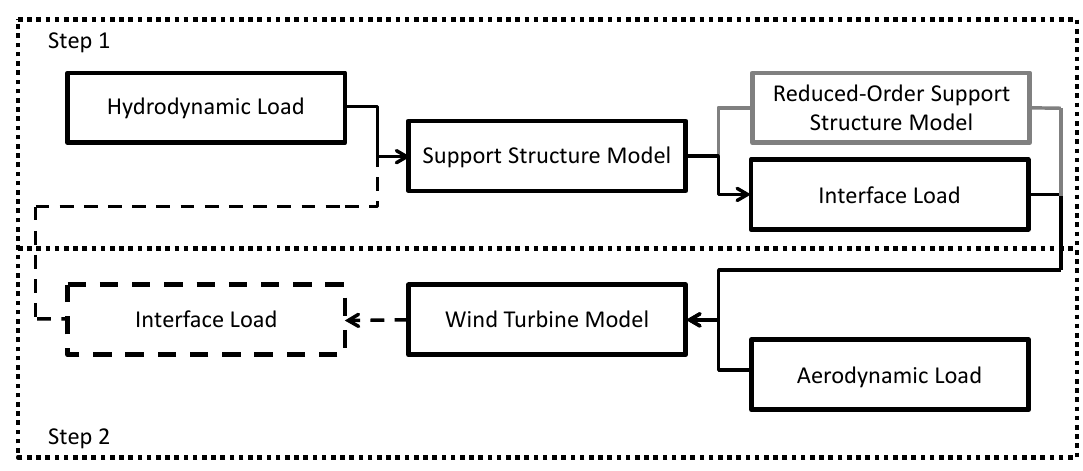
Figure 2. Schematic representation of the sequential design procedure for offshore wind